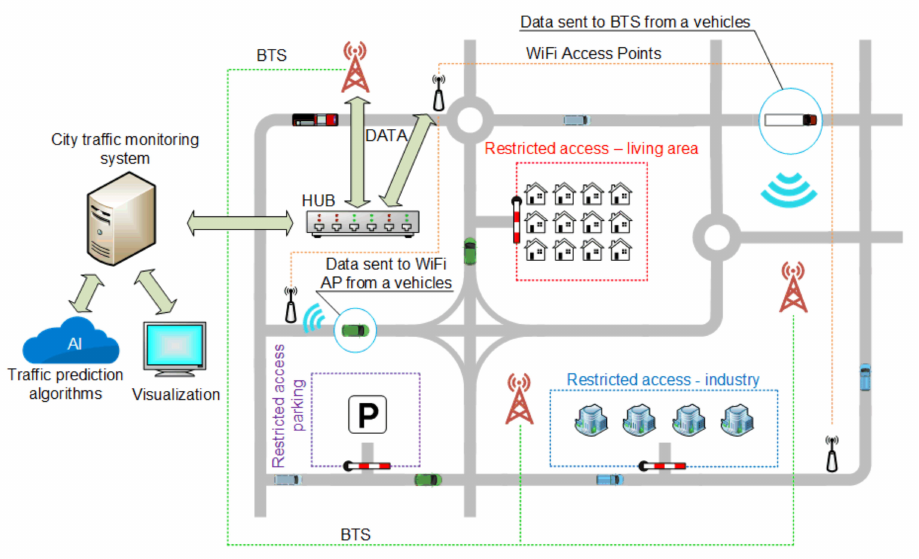
Figure 2. Concepts of the Smart City tra ffi c monitoring and control